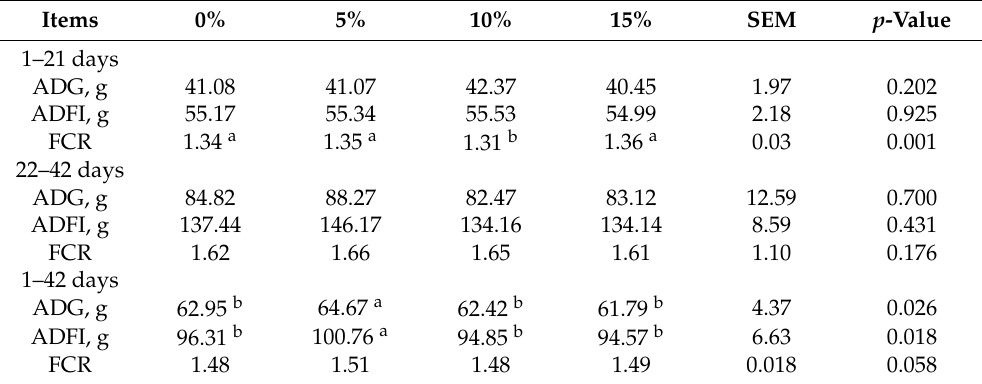
Table 3. The effects of adding fermented feed on the growth performance of broilers.